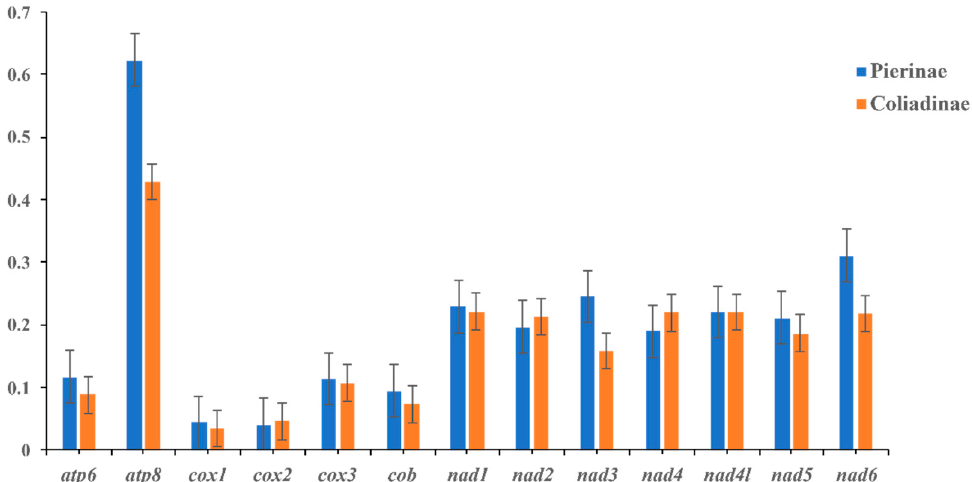
Figure 4. Evolutionary rate of each PCG among Pierinae and Coliadinae species. The ratio of the rate of non-synonymous substitutions to the rate of synonymous substitutions ( dN / dS ) for each PCG.